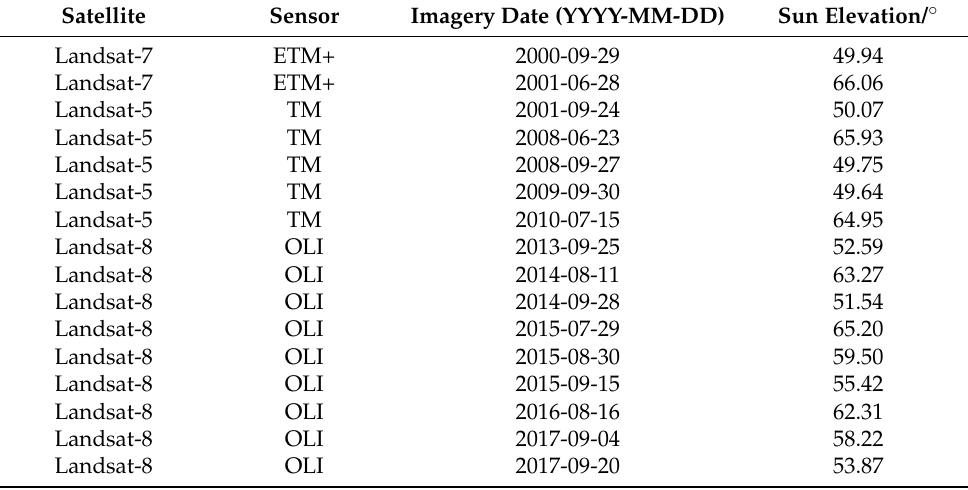
Table 1. The Landsat data for the Chhota Shigri glacier used in this study.